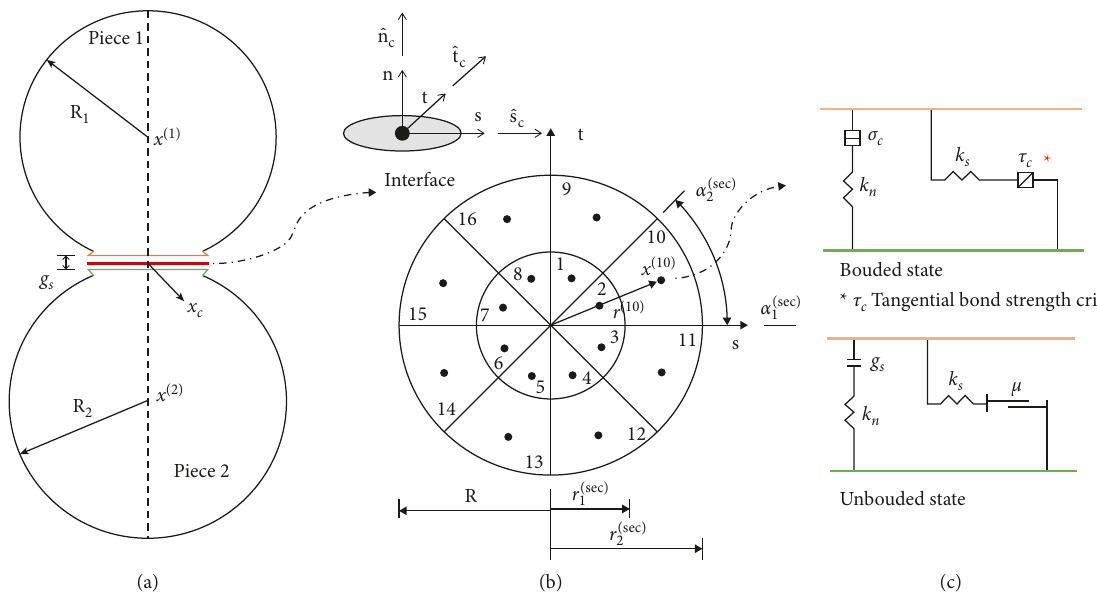
Figure 1: The nonlinear discrete interface bonded model: (a) contact, (b) interface discretization, and (c) bonded logical